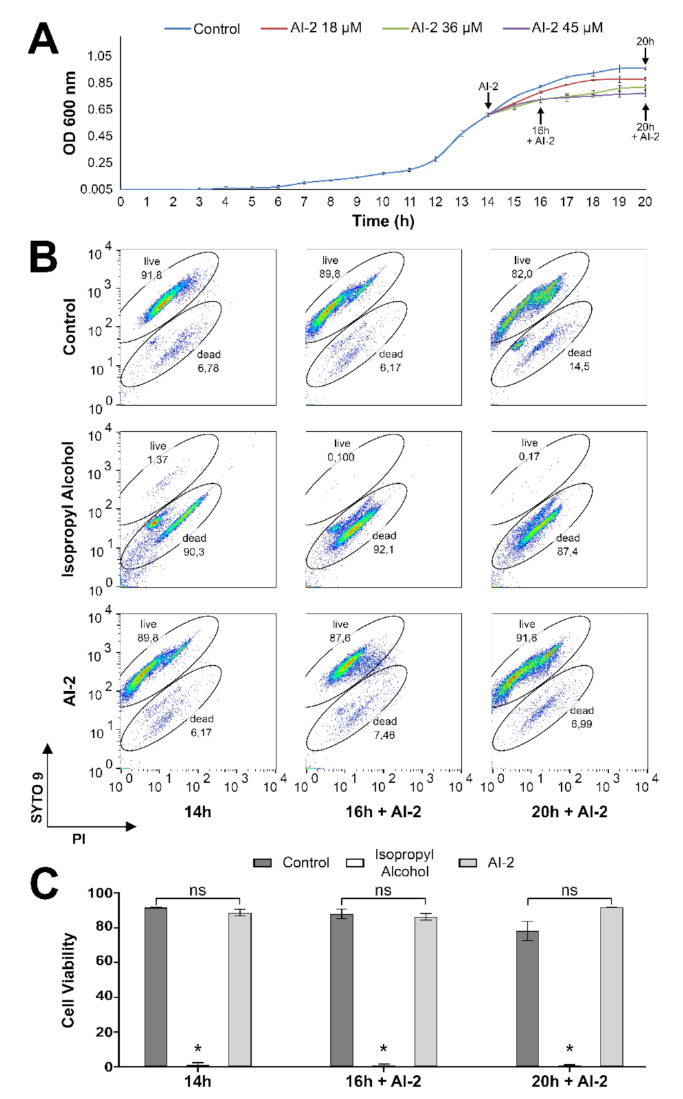
Figure 1. Effects of AI-2 on Z. mobilis growth rate and viability. ( A ) An initial Z. mobilis culture was established, in 5 mL of liquid MM, from an isolated colony, grown in solid MM. This culture was incubated at 30 ◦ C (without shaking) for 24 h, when aliquots were taken and used to inoculate a flask containing 80 mL of liquid MM, to an OD 600 = 0.05. This flask was then incubated under the same conditions and cell growth was monitored hourly by OD 600 readings. When this culture reached mid-exponential growth phase (at t = 14 h), it was subdivided into four vials of 20 mL each. AI-2 was then added to these cultures, at different concentrations (0, 18, 36, and 45 µ M). Next, the cultures were re-incubated, as described above, and the OD 600 continued to be monitored, until all reached stationary phase. OD 600 readings shown in the graph represent the averages ± SEM from three independent experiments. Aliquots (2 mL) were taken for RNA extraction at the times indicated by the arrows, namely: (i) t = 14 h (before addition of AI-2); (ii) t = 16 h + AI-2 (treated with 45 µ M AI- 2); (iii) t = 20 h + AI-2 (treated with 45 µ M AI- 2); and (iv) t = 20 h (not treated with AI-2). See text for further details. ( B ) Representative dot plots showing SYTO 9 and PI fluorescence obtained by flow cytometry in cells grown in the absence of AI-2 (control), treated with 70% isopropyl alcohol (positive control), and treated with 45 µ M AI-2, at the same incubation times highlighted in panel ( A ). ( C ) Quantification of percentages of live and dead cells. The results are presented as the mean ± SEM of three independent experiments and * represents statistically significant differences in relation to the respective controls (AI-2 untreated cultures), after a two-tailed t -test, using p < 0.05 as a threshold; ns represent statistically non-significant